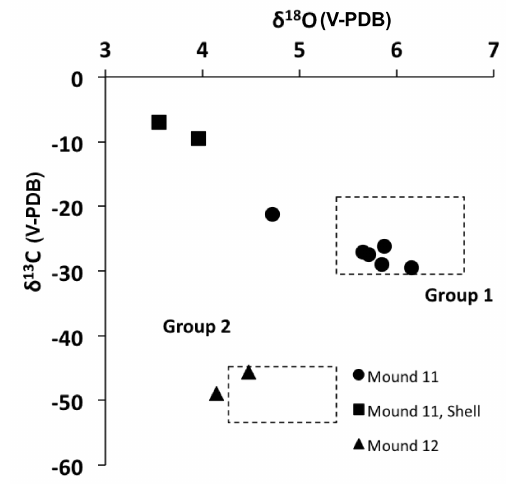
1049 Fig. 5. δ 13 C vs. δ 18 O plot of carbonate material sampled from var- ious locations during SO206 (solid symbols). The grouping was based on isotopic, petrographic, mineralogical, and morphological similarities according to Han et al. (2004). All values refer to the V-PDB